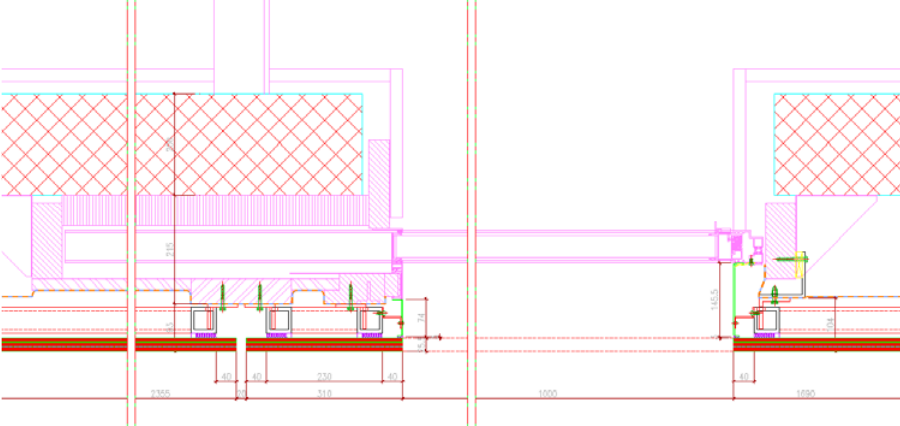
Fig. 4: Horizontal section in sliding window